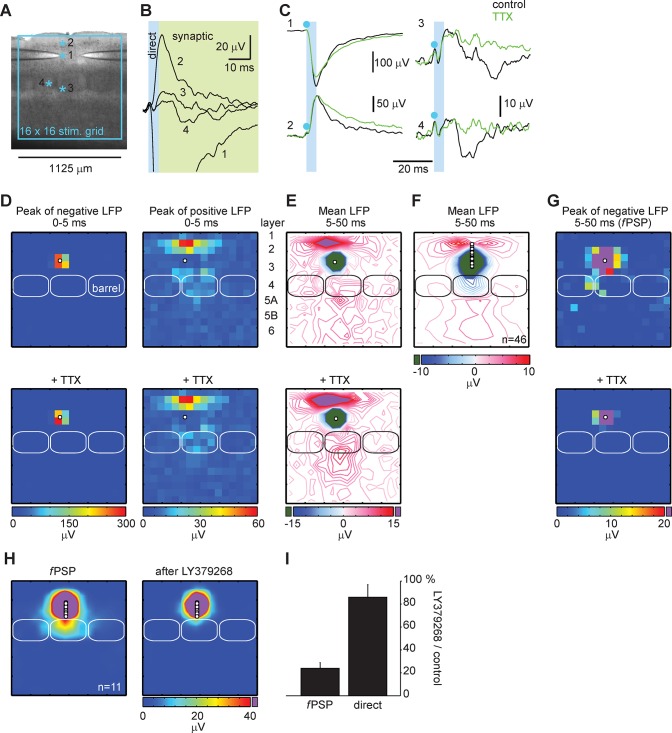
Field postsynaptic potentials (fPSP) are evoked by laser scanning photostimulation with glutamate uncaging in slice.
A, One to two glass pipettes were placed in barrel cortex slice to record local field potentials. Responses where evoked with glutamate uncaging at sites positioned in a 16 × 16 grid with a 75 μm spacing. B, Examples of evoked local field potentials. Direct and synaptic responses could be distinguished based on their latency. The numbers refer to the stimulation sites shown in A. C, The black traces are the same as in B. Synaptic events were blocked by 100 nM TTX (in green). Blue dots indicate the stimulation onset and the light blue shade the time window for the rising of direct responses. D, Example of a map reporting with colors the peak amplitude of direct responses evoked 0 to 5 ms after the stimulus onset. Top panels are in control conditions, the bottom panels are in the presence of TTX. Left panels show the negative potentials, the right the positive potentials. The white circles indicate the position of the recording, the rectangles the position of barrels in the slice. All panels are from the same recording. E, Example of a map in control condition (top) and in the presence of TTX (bottom) showing the mean amplitude of local field potentials evoked 5 to 50 ms post stimulus onset. In blue, the isolines of regions with negative potentials; in red, the isolines of regions with positive potentials. The green and purple show regions where responses were larger than 15 μV. Same recording as in D. F, Group-average isoline map of recordings performed in layer 2/3. The isolines show the regions in the map where the mean amplitude of potentials evoked within the 5–50 ms time window were negative (blue) and positive (red). G, Example of a color map reporting the peak amplitude of negative potentials (fPSP map) evoked in control condition (top) and in the presence of TTX (bottom). Same recording as in D and E. H, Group-average map for recording performed in layer 3 prior (left) and after application of LY379268, an agonist of group 2 metabotropic glutamate receptors (right). I, The effect of LY379268 on synaptic events evoked by stimulations in layer 4 or on the direct responses evoked by stimulations in the vicinity of the recording pipette.